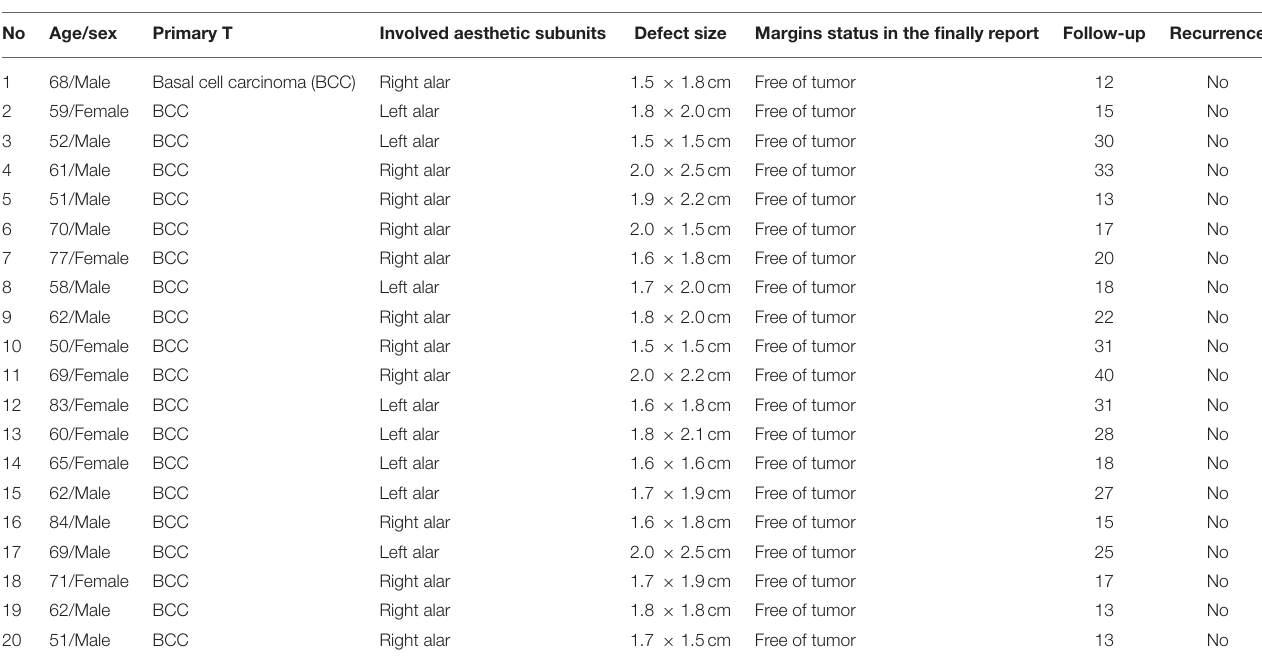
TABLE 1 | Characteristics of